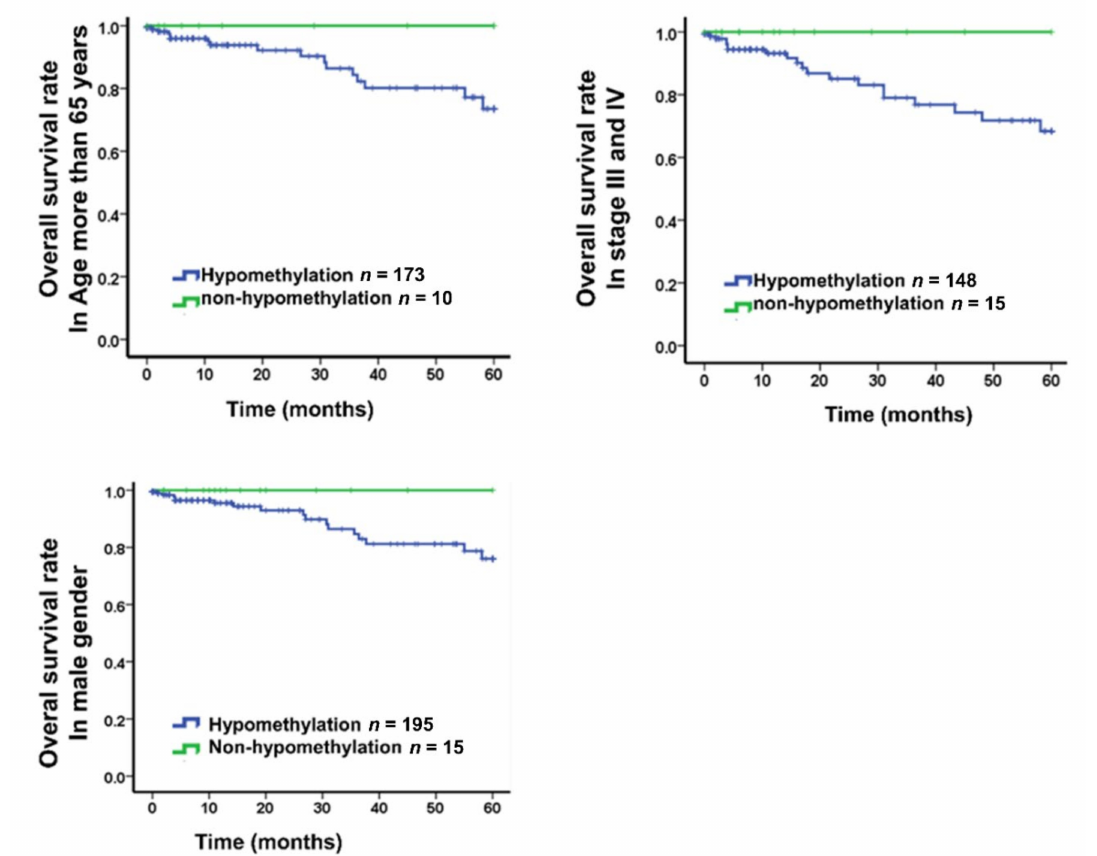
Figure 8. Kaplan–Meier survival curves were constructed to compare the overall survival between CRC patients with hypomethylation and nonhypomethylation of SMAD3 in patients with age > 65, stage III-IV, and male gender. SMAD3 was defined as hypomethylation when the methylation level in CRC tumors was half that in adjacent normal colorectal